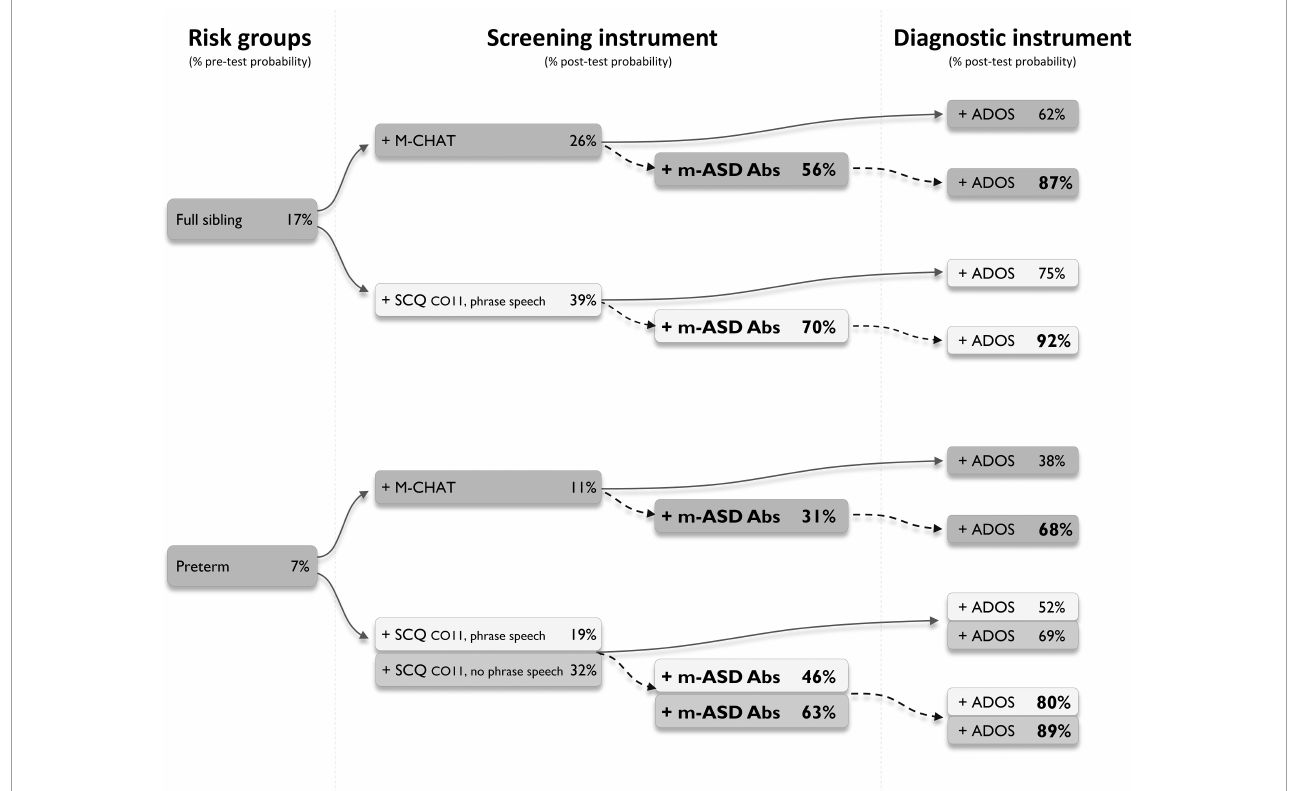
FIGURE2 Simulated diagnostic trajectories with and without additional m-ASD antibody testing. Different diagnostic trajectories were studied, and the stepwise increase in post-test probability for having autism spectrum disorder (ASD) was calculated, when a person would be part of an ASD risk group (full ASD sibling or preterm), would be positive for one of the indicated screening instruments (M-CHAT or SCQ), and would be positive for the ADOS as a diagnostic instrument (solid arrows). For each trajectory, the added value of testing for anti-UH-ASD.1/5/8/12 antibodies was calculated (dashed arrows). Pre-test probability for full siblings was obtained from Killick et al. (2012), Maenner et al. (2020), for preterm births from Lardeux et al. (2016). Positive likelihood ratios to calculate post-test probabilities for M-CHAT were obtained from Hansen et al. (2019), for early SCQ from Agrawal et al. (2018), and for ADOS from Randall et al. (2018). ADOS, Autism Diagnostic Observational Schedule; CO, cut-off; M-CHAT, Modified Checklist for Autism in Toddlers; m-ASD Abs, maternal autism spectrum disorder antibodies; SCQ, Social Communication